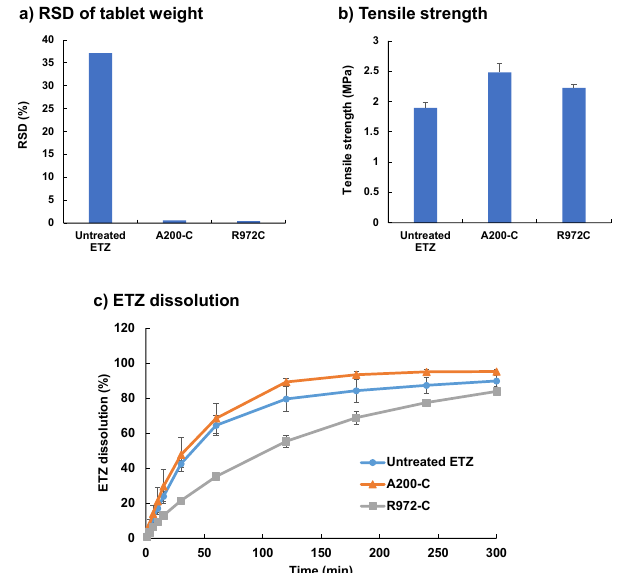
Figure 6. Effect of dry coating of silica nanoparticles by Comil on the properties of ETZ tablets: ( a ) relative standard deviations (RSDs) of the weights of 50 tablets prepared by a single-punch tableting machine, ( b ) tensile strengths of the tablets ( n = 5), and ( c ) profiles of ETZ dissolution from the tablets ( n = 3). Values are expressed as means ± standard deviations of the means.